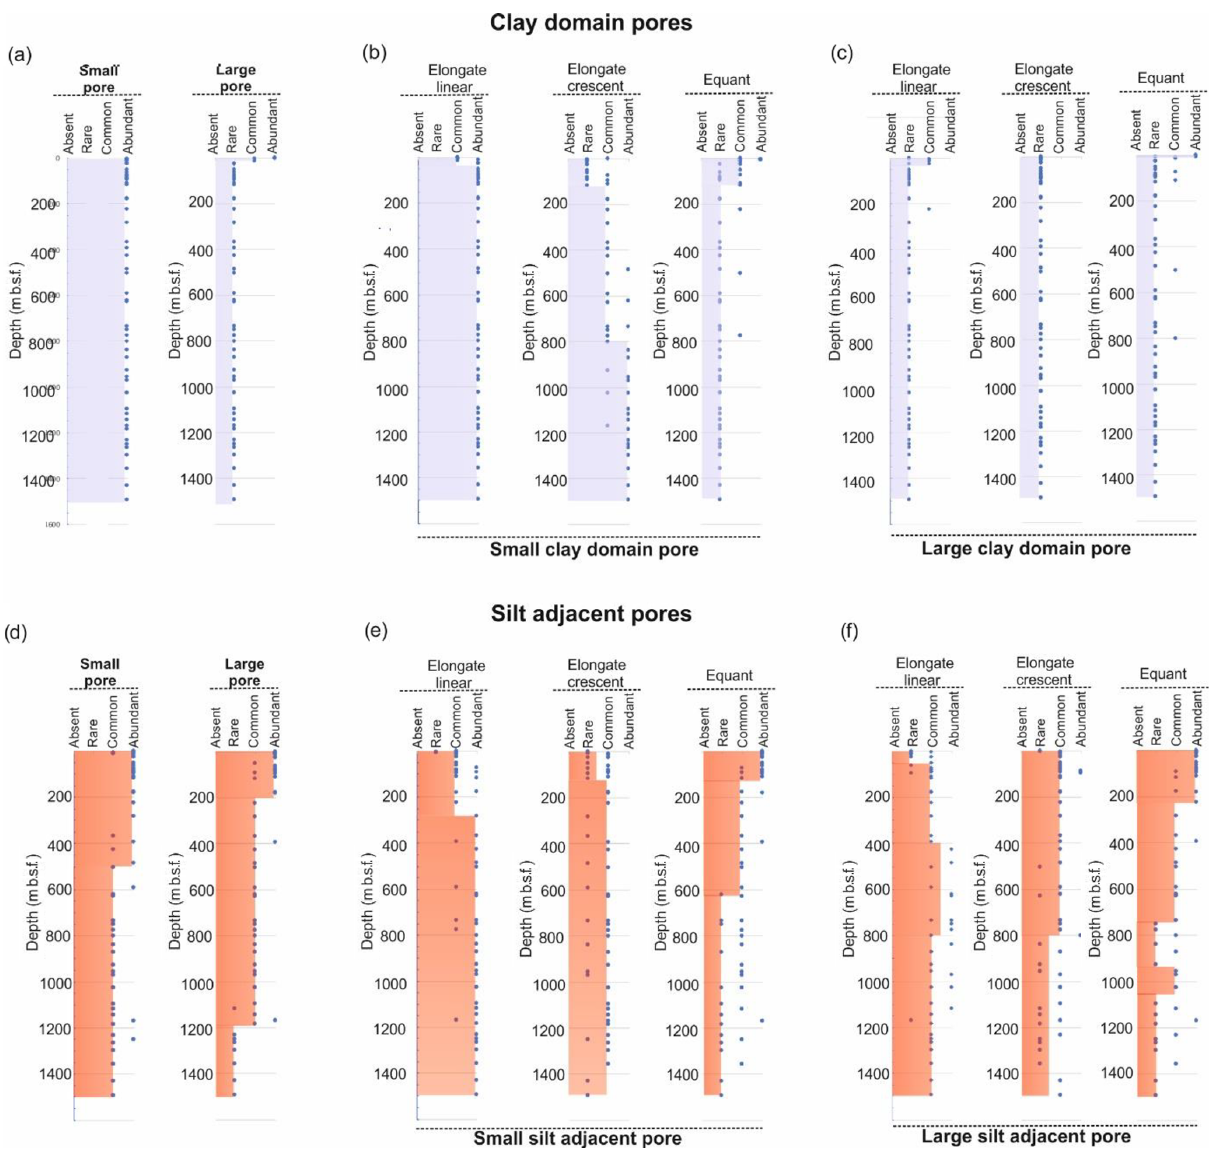
Figure 8. Pore type summary for clay-domain (a–c) and silt-adjacent (d–f) pore types. (a) Abundance of small and large clay-domain pores. (b–c) Depth progression of small and large clay-domain pore morphologies. (d) Abundance of small and large silt-adjacent pores. (e– f) Depth progression of small and large clay-domain pore morphologies. Abundant: >25% pores, common: 2%–25% pores, rare: 0%–2% pores, absent: not